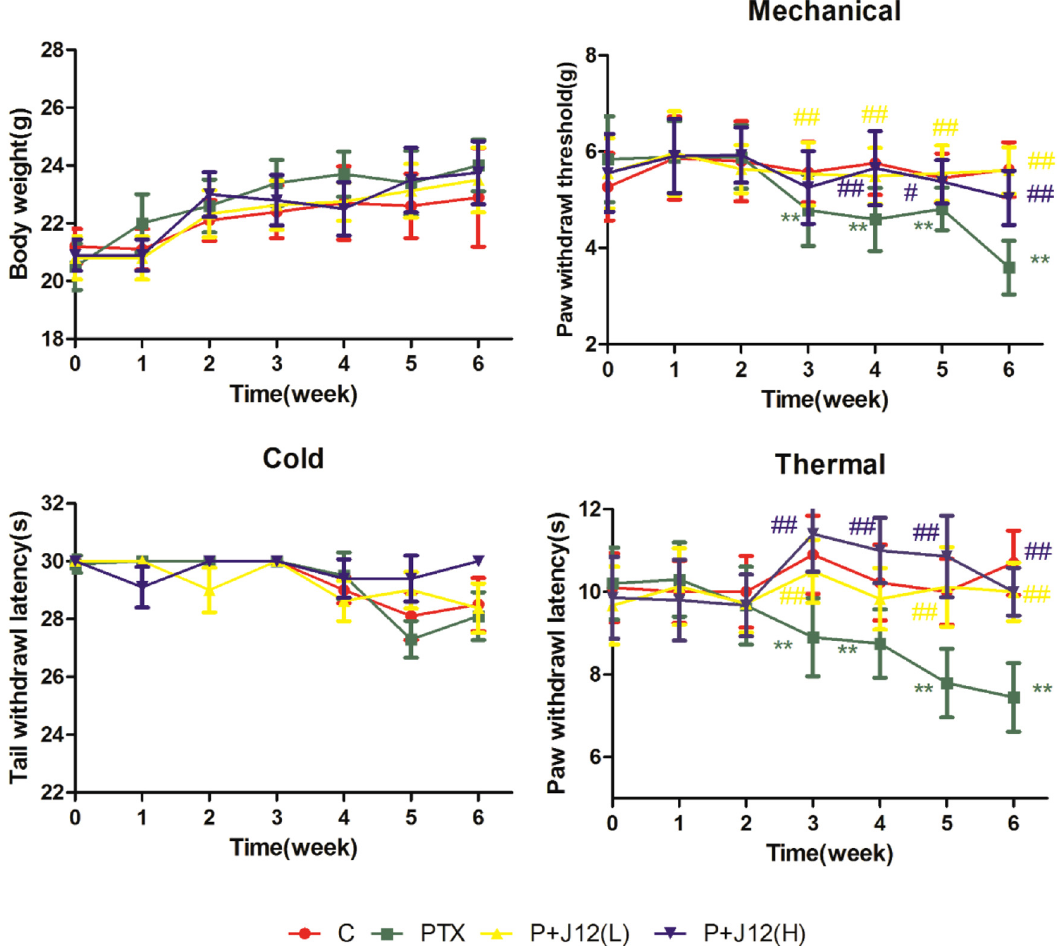
Fig. 1. J12 was pretreated 2 weeks before PTX administration. (A) The effect of J12 on body weight in mice treated with or without PTX. No signi fi cant difference on model group and J12 treated group in mice. (B) Paw withdrawal threshold was signi fi cantly decreased at week 3 and maintained for more than 4 weeks in mice treated with PTX. (C) PTX did not have signi fi cant effect on cold tail withdrawal latency. (D) J12 at dosages of 5g/kg and 10 g/kg both attenuated paclitaxel-induced mechanical hyperalgesia and thermal nociception. Similarly, no effect is observed with J12 on mice treated with or without PTX. **vs Control, p < 0.01; # vs PTX, p < 0.05; ## vs PTX, p <